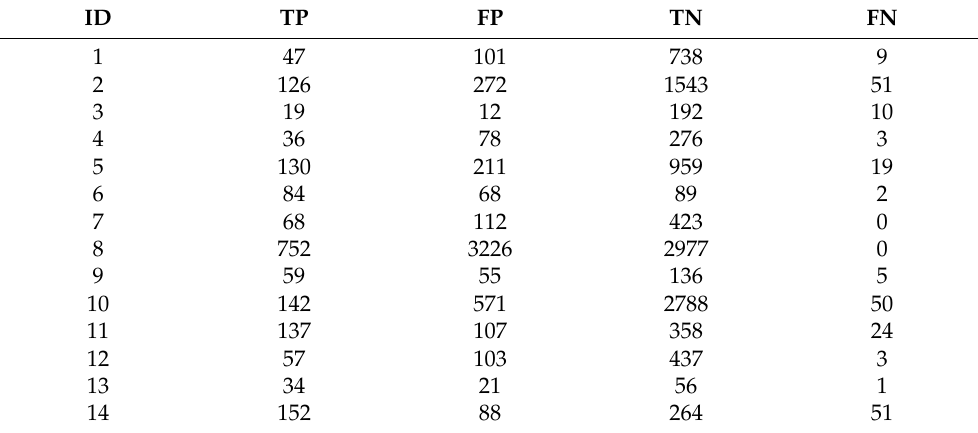
Table 1. Alcohol Use Disorder Identification Test abbreviated version